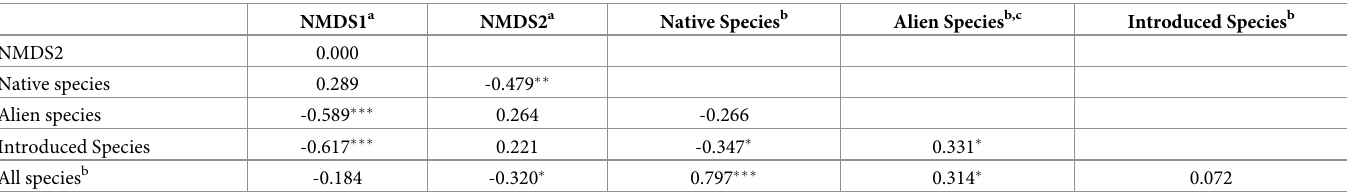
Table 5. Pearson correlation matrix for the NMDS axes shown in Fig 3 and species